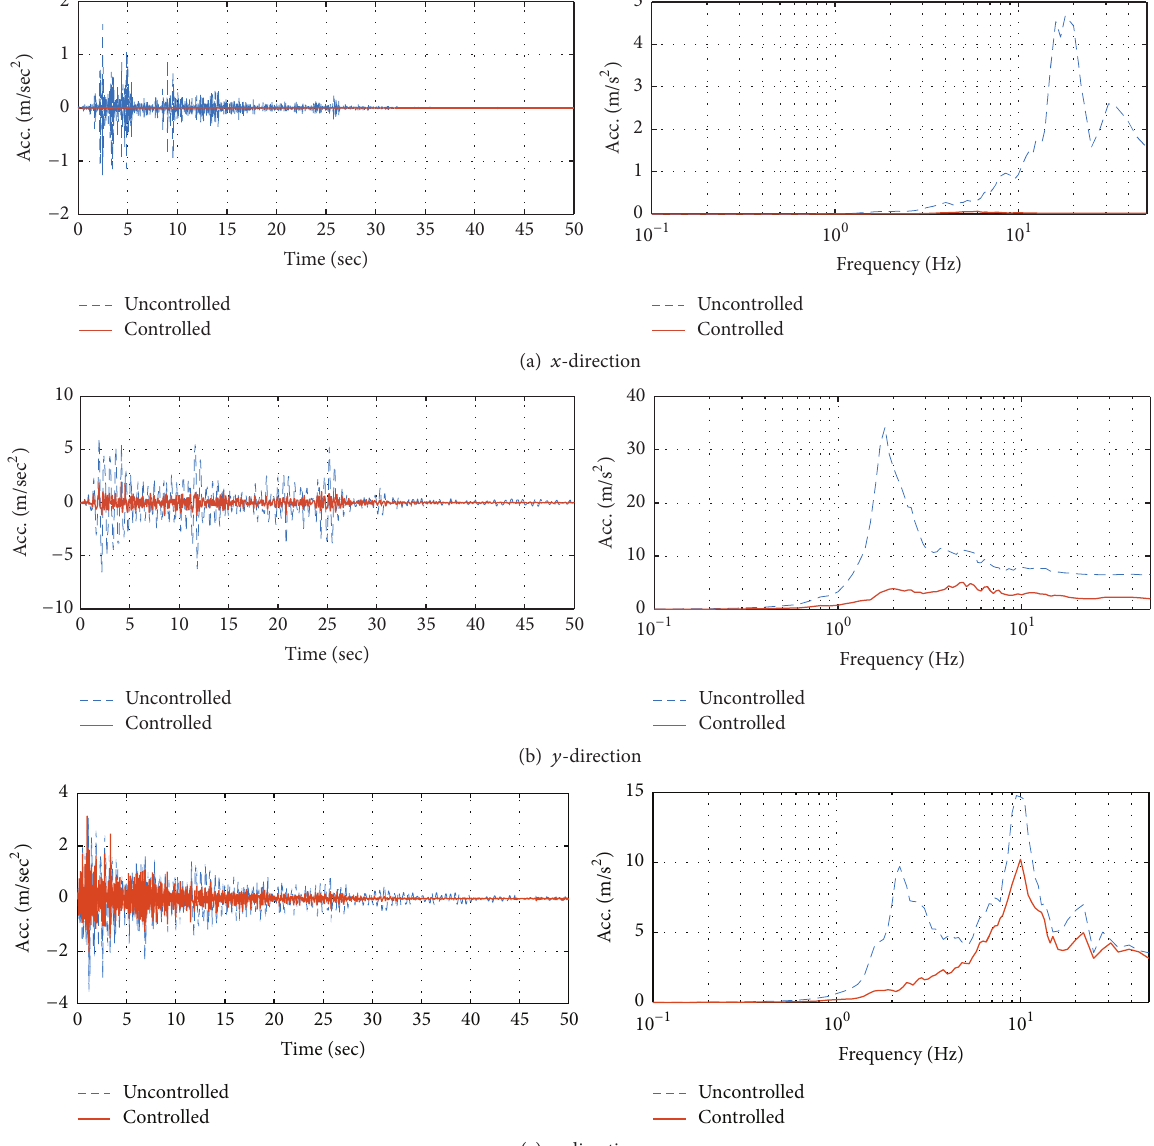
Figure 14: Response of piping system subjected to El Centro